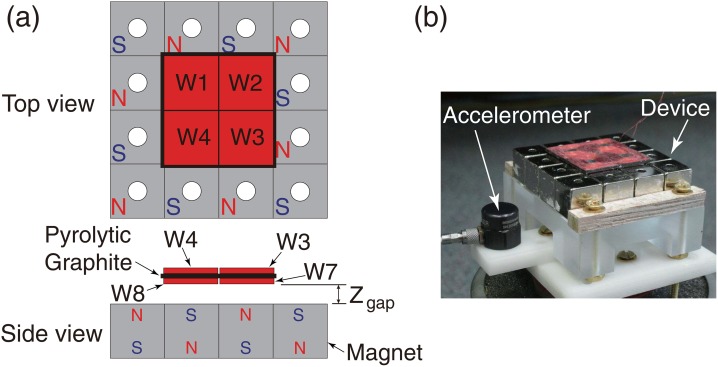
Prototype Device.(a) Schematic diagrams, and (b) the experiment apparatus (the shaker, the electrical load, and the oscilloscope are not shown).